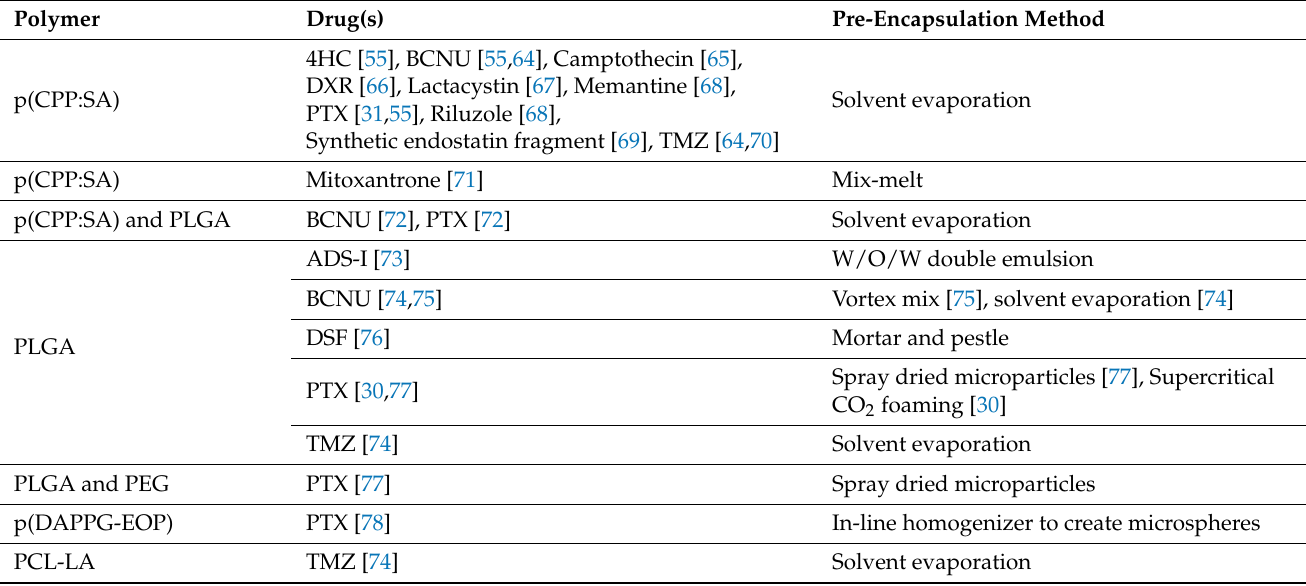
Table 1. Table of drug delivery devices formulated by compression molding for the treatment of